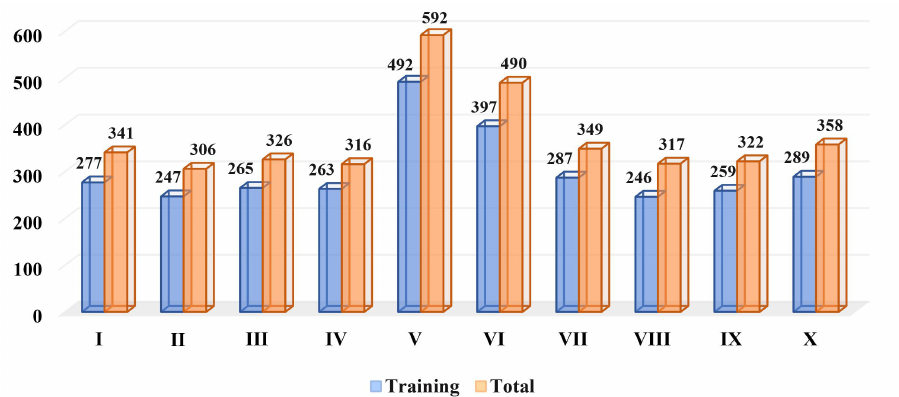
Figure 2. Number statistical results for the training set and total set of the scanned map